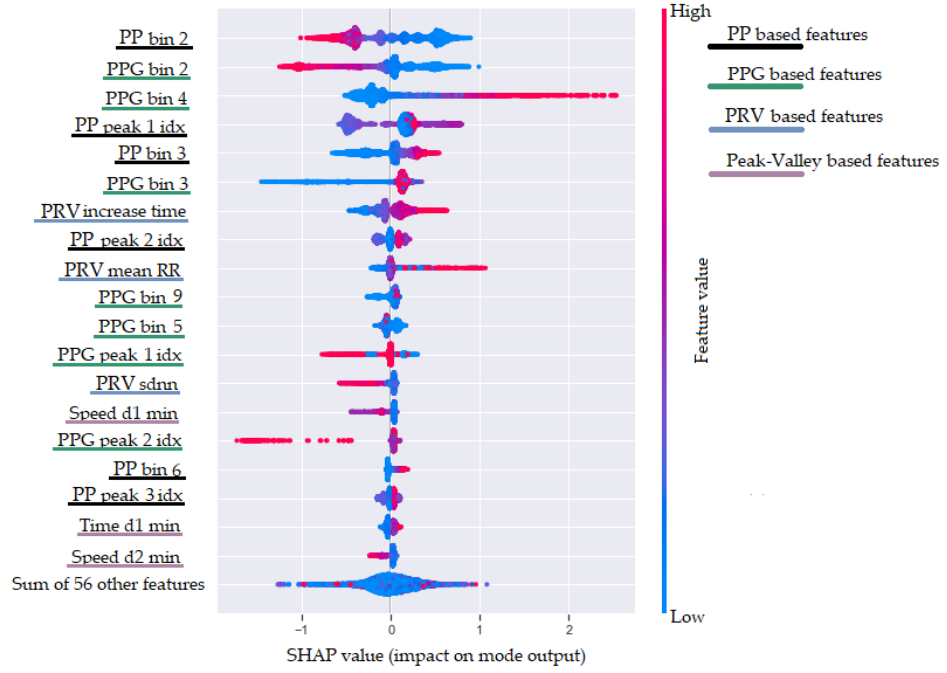
Figure 10. SHAP feature importance measured as the mean absolute Shapley